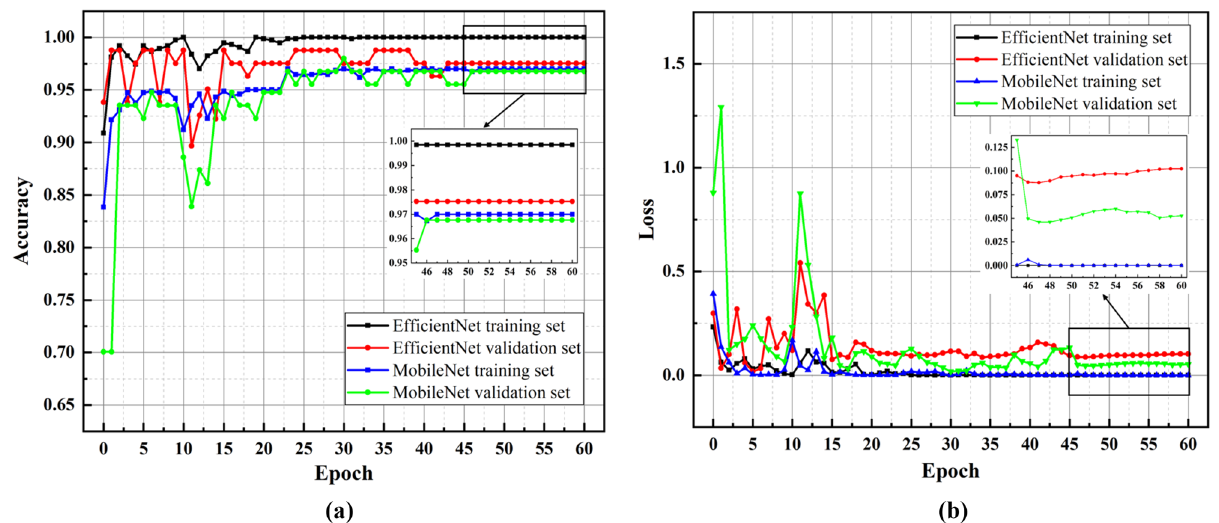
Figure 5. The MobileNet model and the EfficientNet model training results ( a ) Line graph of the accuracy of the training set and validation set with the epoch of training; ( b ) Line graph of the loss value of the training set and the validation set with the epoch of training.